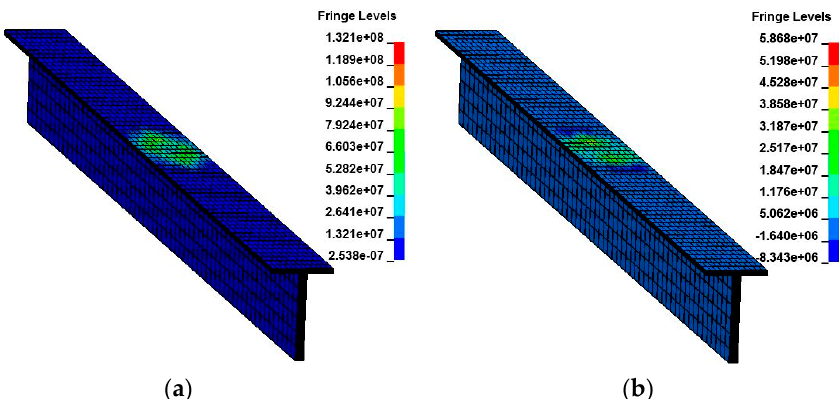
Figure 16. Contours of von Mises and pressure in the T stripper. ( a ) Contours of von Mises stress; ( b ) pressure contours.